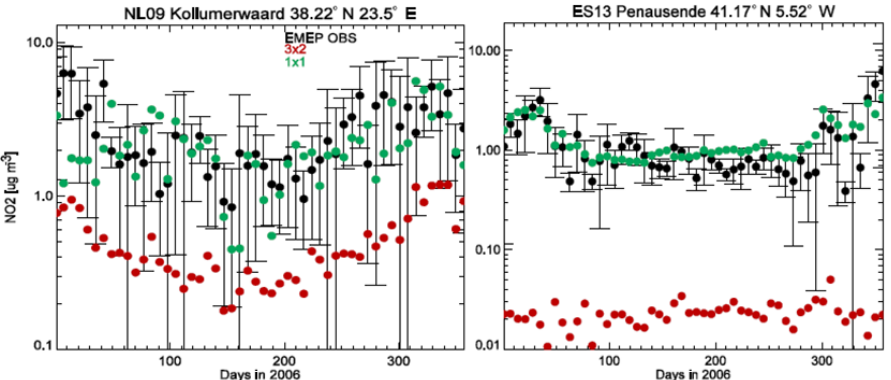
Figure 6. Comparison of weekly TM5-MP [NO 2 ] sampled at 13:00UT each day during 2006 with observed [NO 2 ] (µgm − 3 ) . The selected sites shown are in the Netherlands (left) and Spain